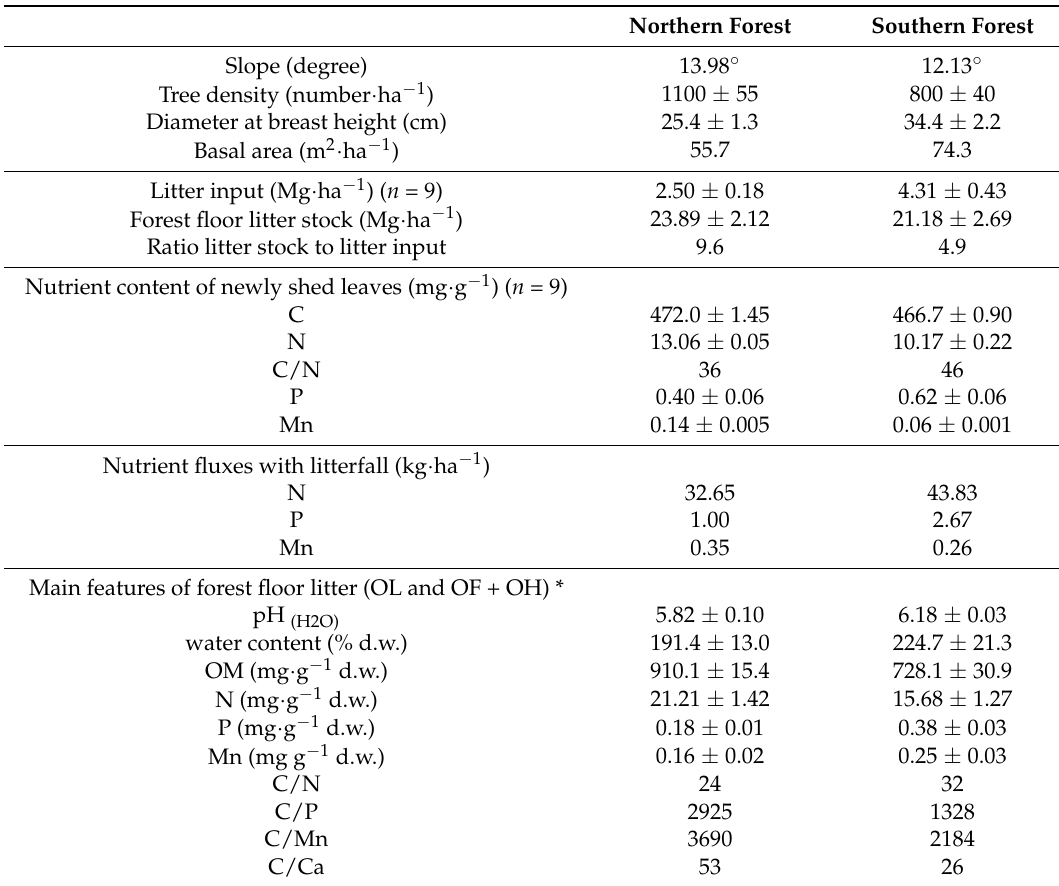
Table 2. Stand, litterfall and forest floor features of two 75-year-old beech forests in the Apennines mountains